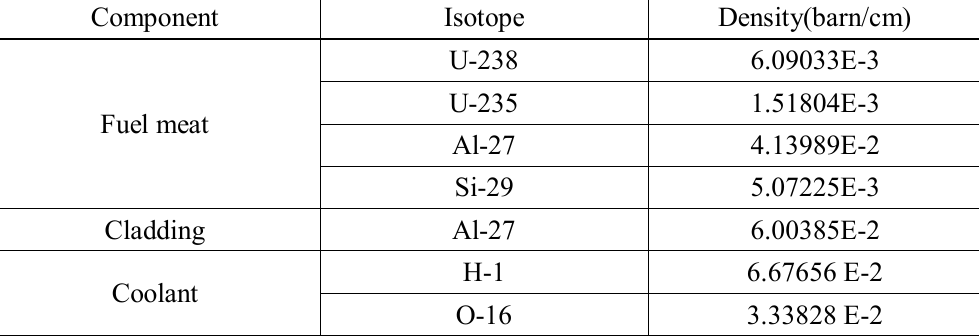
Figure 1. Configurations of JRR-3M fuel assemblies Table I. Atomic density of the JRR-3M fuel